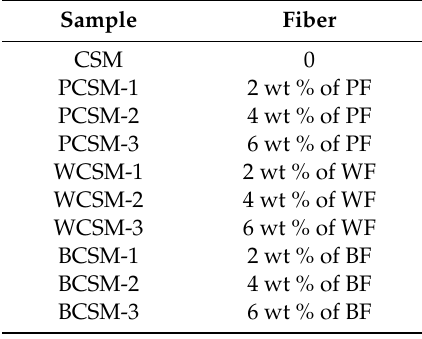
Table 1. Experimental Formulations of SM-Based Adhesives (Since the amount of SM, deionized water and the crosslinking agent is the same in all samples, they are not listed in the table). Sample Fiber CSM